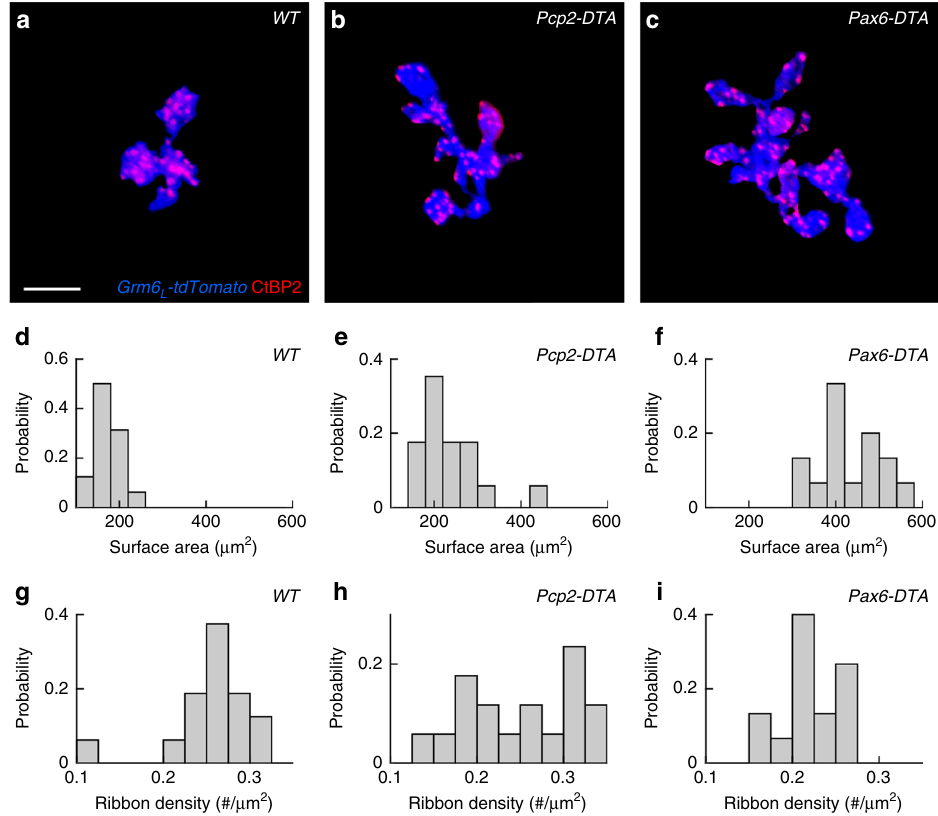
Fig. 6 Cell density regulates RBC axon and synapse development. a – c Maximum intensity projection of RBC axon terminals labeled by transgenic expression of tdTomato ( Grm6 L -tdTomato in blue) and presynaptic release sites stained for the C-terminal binding protein 2 (CtBP2, red) in wild-type ( a ), Pcp2-DTA ( b ), and Pax6-DTA ( c ) retinas. For visual clarity, RBC axons and their synapses were digitally isolated in Amira. Scale bar indicates 5 μ m. d – f Summary data of RBC axon surface areas in wild-type ( d , n = 16 RBCs), Pcp2-DTA ( e , n = 17 RBCs), and Pax6-DTA ( f , n = 15 RBCs) mice. By Kruskal – Wallis one-way ANOVA testing, RBC axon surface areas in Pcp2-DTA and Pax6-DTA retinas were greater than in wild-type retinas ( p < 0.02 and p < 10 − 8 , respectively), and RBC axon surface areas were greater in Pax6-DTA than in Pcp2-DTA retinas ( p < 0.003). g – i Population data (mean ± SEM) from wild-type ( g , n = 16 RBCs), Pcp2-DTA ( h , n = 17 RBCs), and Pax6-DTA ( i , n = 15 RBCs) retinas show that synapse density tends to decrease with increasing axon size. By Kruskal – Wallis one-way ANOVA testing, RBC synapse densities in Pcp2-DTA and Pax6-DTA retinas were lower than in wild-type retinas ( p < 0.003 and p < 0.02,